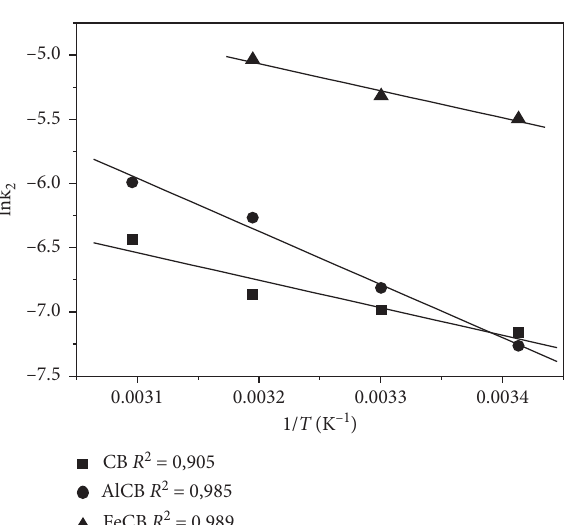
Figure 11: Arrhenius plots of phenol red adsorption onto CB, AlCB, and FeCB.